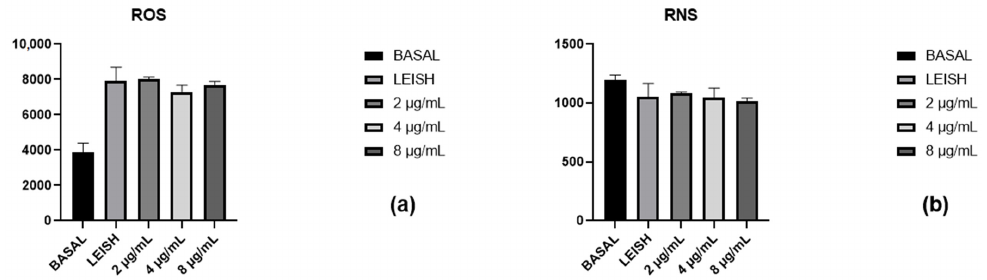
Figure 4. Evaluation of the effect of ACW-02 on the production of reactive ( a ) oxygen and ( b ) nitrogen species. Basal: Macrophages uninfected and untreated. Leish: Macrophages infected with L. amazonensis and untreated. ANOVA followed by Tukey’s multiple comparisons test.